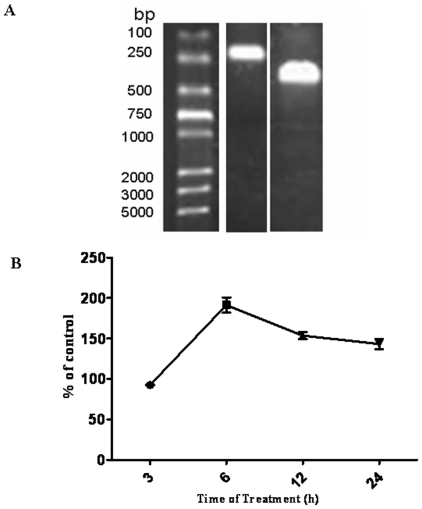
Quantitative RT-PCR analysis of PrP106–126 effect on mRNA expression of CD36.A. Electrophoresis of RT-PCR-amplified CD36 (294 bp) and β-actin (223 bp) on 8% agarose gel and stained with ethidium bromide. B. Time course of CD36 mRNA Expression upon exposure to PrP106–126 in BV2 microglia. Cells were treated for 3, 6, 12 h, or 24 hours with 100 µM PrP106–126. Total mRNA was isolated and reverse-transcribed. The mRNA level of CD36 were measured by quantitative RT-PCR. Expression of a receptor at each time point is expressed as a percentage of expression in control cells exposed to 100 µM scrambled PrP106–126 only for the same time. All data are mean ± s.d. of triplicate samples and are representative of an experimental n of 3 or 4. *, P<0.05.